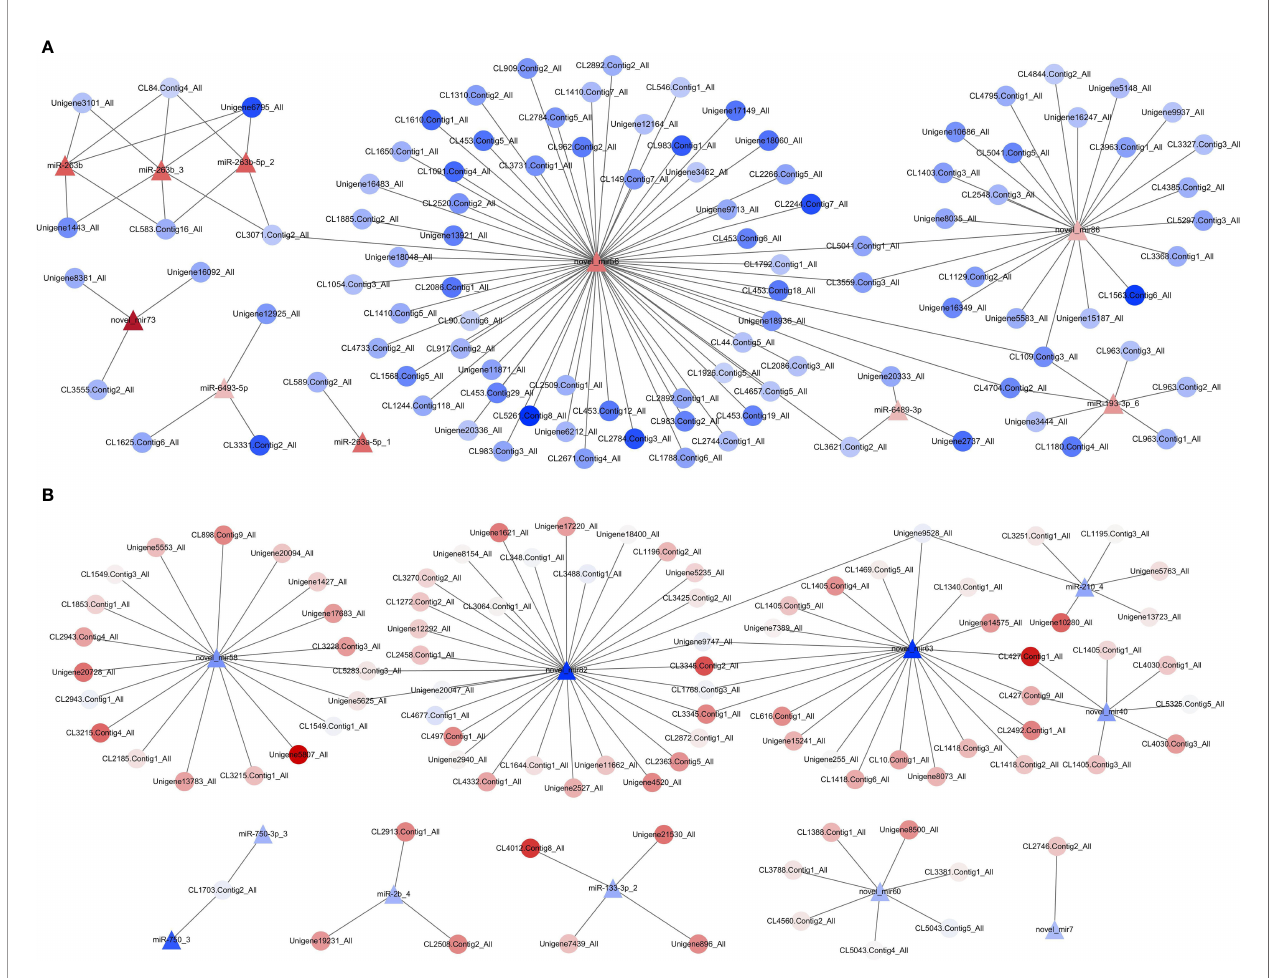
FIGURE 8 | Network analysis for miRNA/mRNA interaction. (A) MiRNA – mRNA network was formed by 10 upregulated DEMs and 119 downregulated DEGs. (B) MiRNA – mRNA network was formed by 11 downregulated DEMs and 103 upregulated DEGs. Red indicates that genes (miRNAs and mRNAs) were upregulated, and blue represents that genes (miRNAs and mRNAs) were downregulated; the darker the color, the greater the fold change. △ represents miRNA, and ○ represents mRNA. DEGs, differentially expressed genes; DEMs, differentially expressed